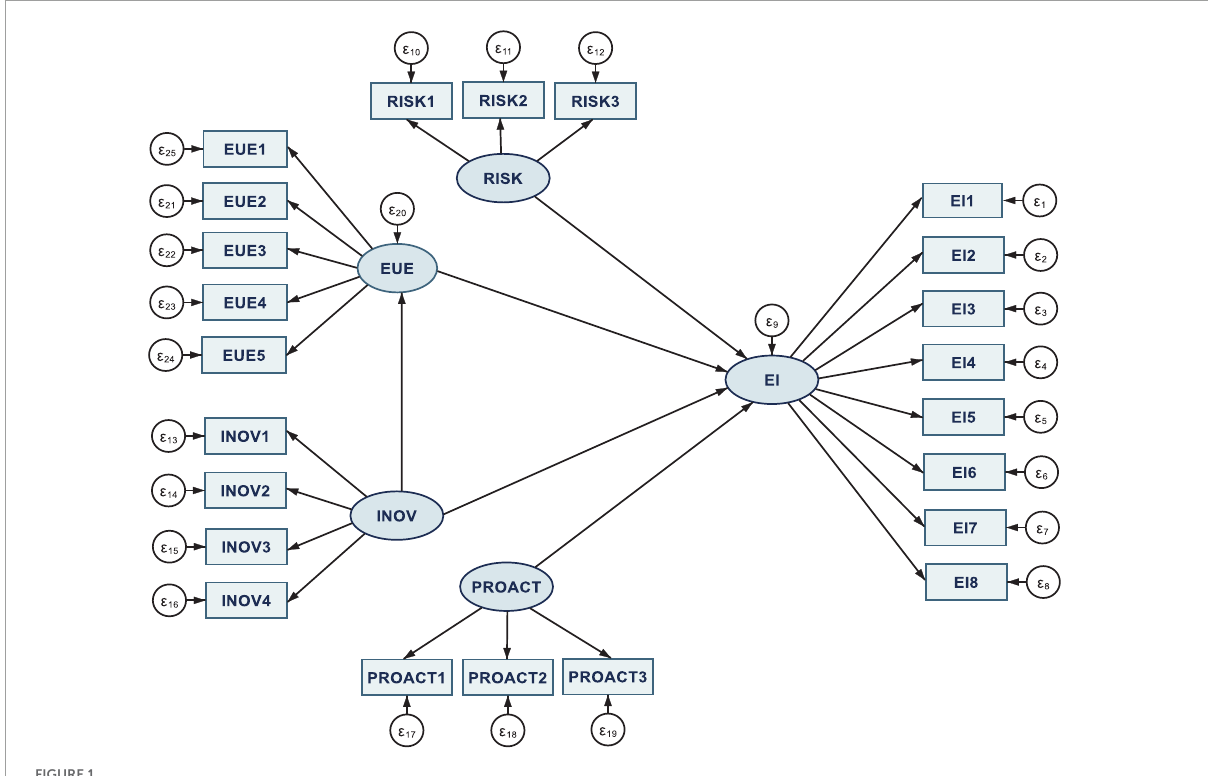
FIGURE1 General configuration of the SEM model. Authors’ contribution in Stata